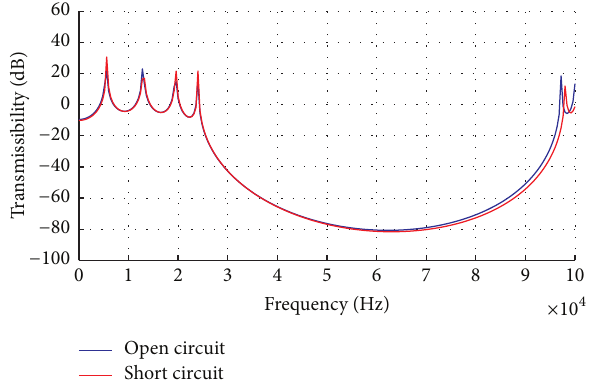
Figure 5: Comparison diagram with short and open circuits.